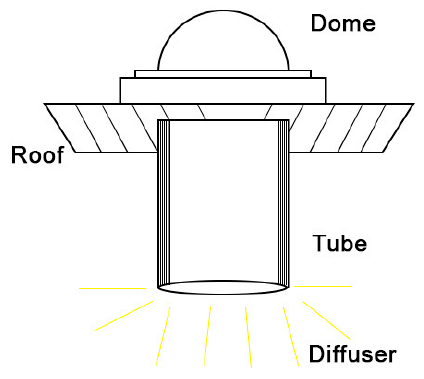
Figure 1. Representation of a lighting system with reflective tube.